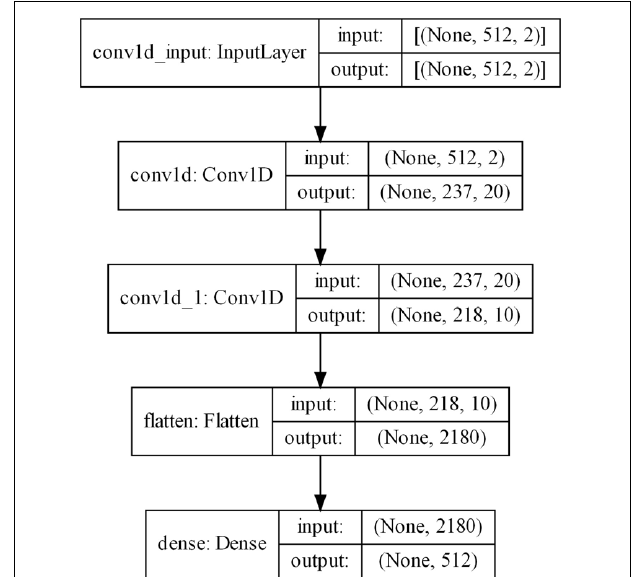
FIGURE 9 | Structure of the proposed neural network.